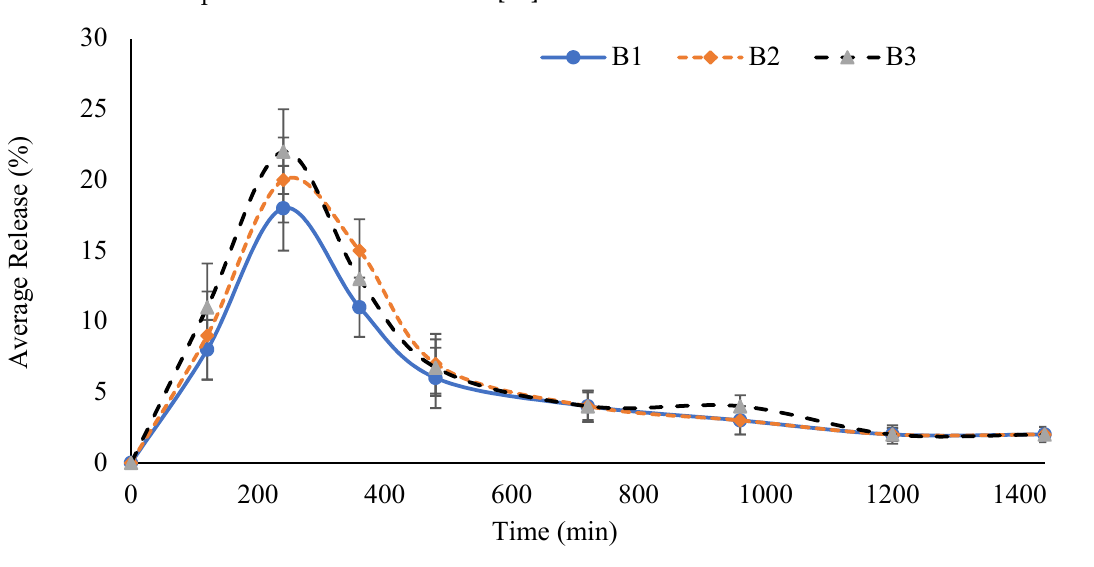
Figure 10. Effect of AA on the release profile of 5-FU at pH 1.2.